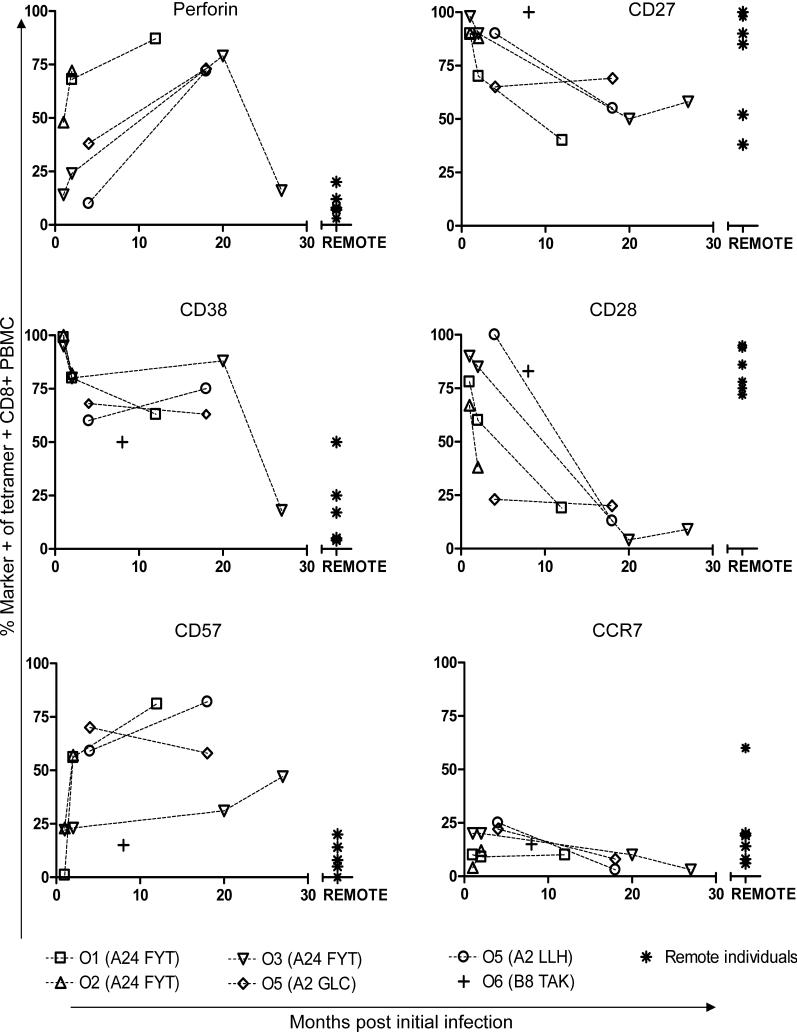
Acutely infected individuals Maintain Activated Mature Effector Cells after Resolution of Acute InfectionRemotely infected individuals show a less mature/activated phenotype but express only low levels of CCR7 and CD62L (Oxford cohort). The y-axis show the frequency of marker-positive cells amongst tetramer-positive CD8+ cells, while the x-axis show the number of months after symptom onset. Data are shown in perforin, CD38, CD57, CD27, CD28, and CCR7: data are derived from six acutely infected individuals in the Oxford cohort (O1–O3, O5, and O6; insufficient cells available for O4) and five remotely infected individuals (OR1–OR5).